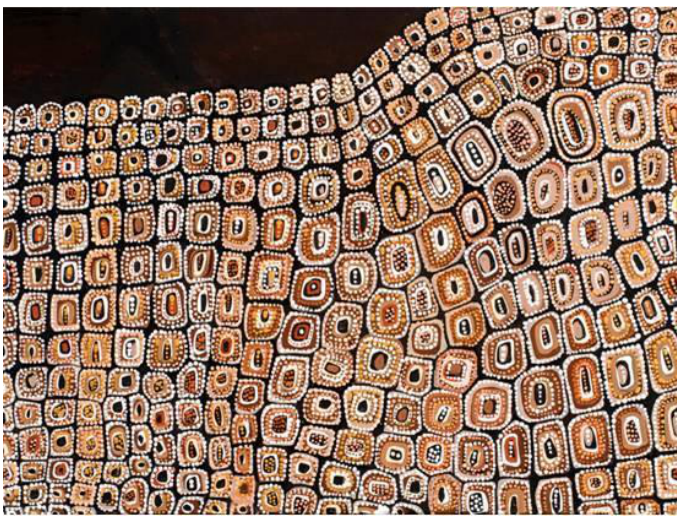
Figure 2. Acrylic on canvas by Belanjee that illustrates the spiritual relationship of the crocodile within cultural